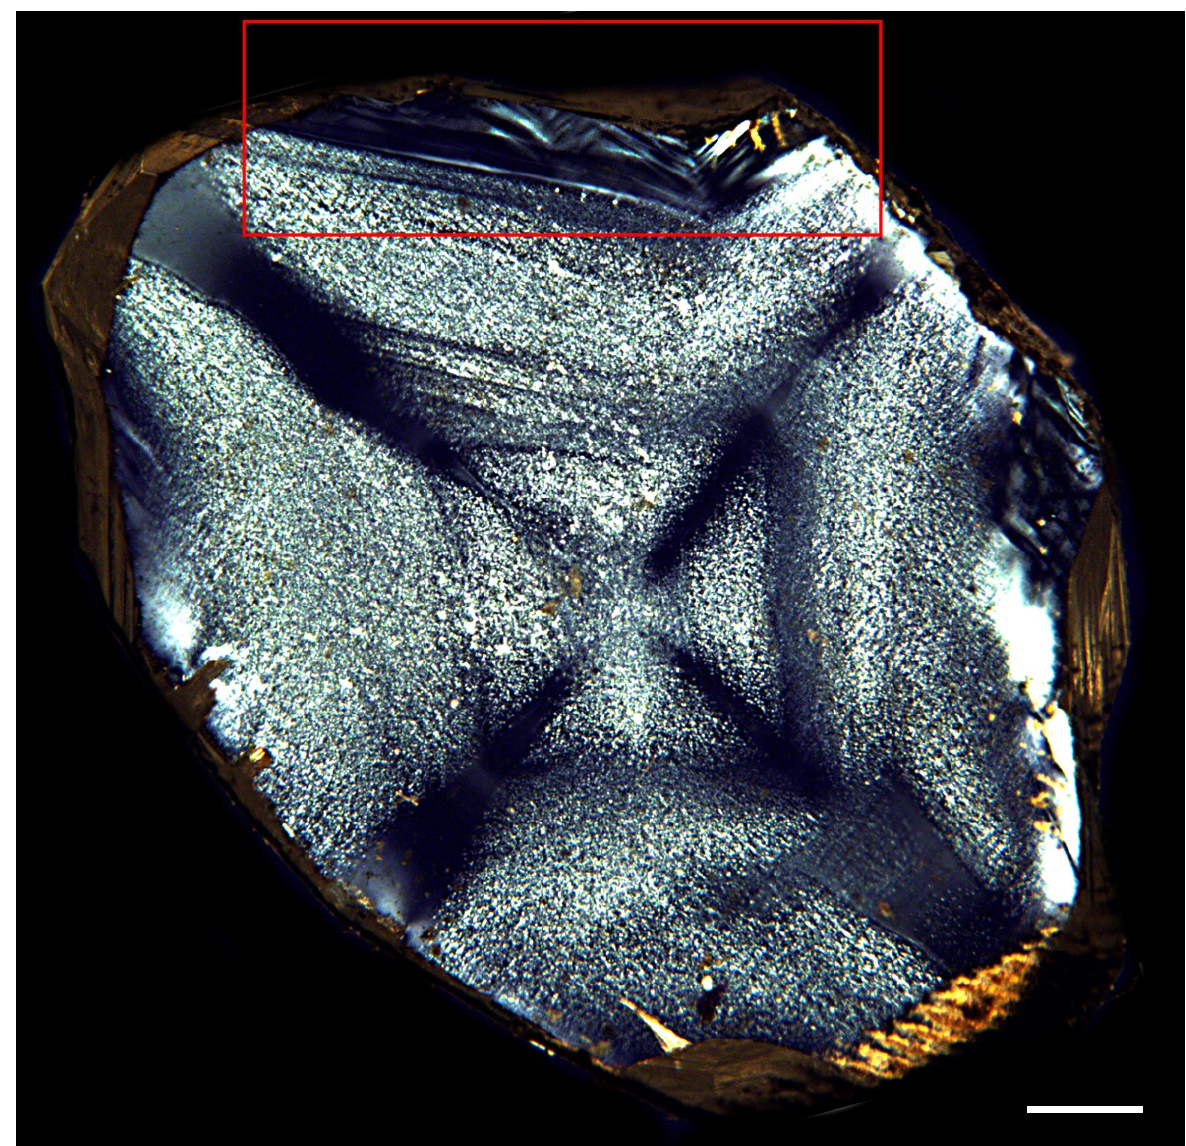
Figure 6. XPL image of a plate, cut from the center of a mixed habit diamond in the <100> direction. The regeneration zoning in the periphery of the crystal is boxed in red. The scale bar is 1 mm.